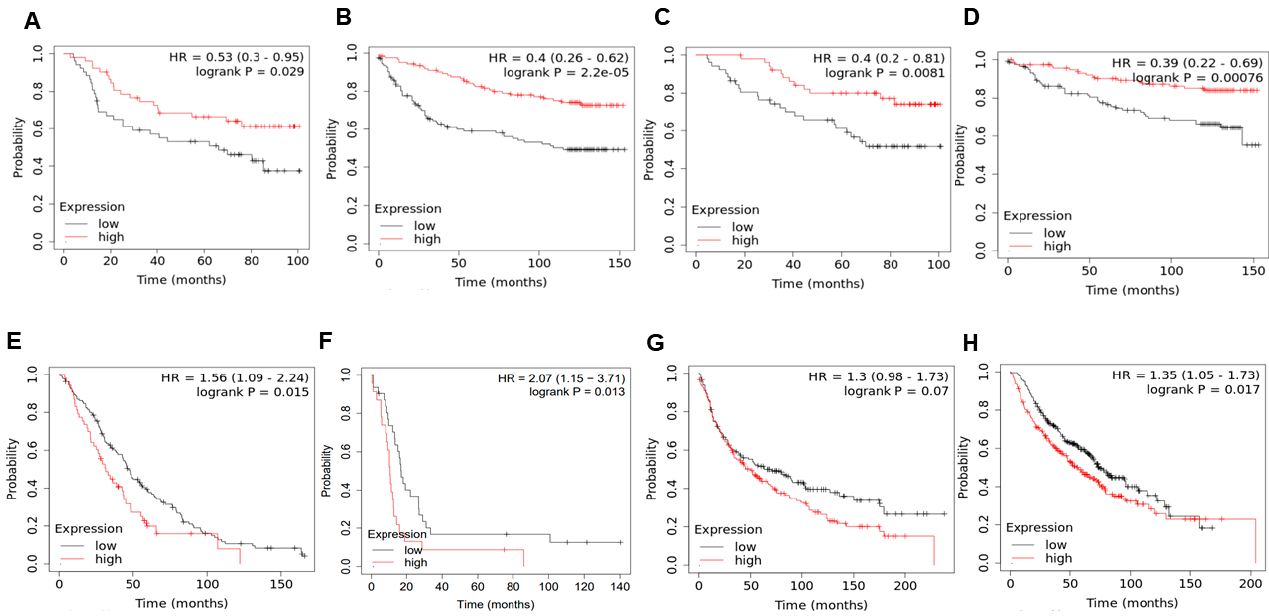
Figure 5. KLF4 correlates with patient survival in a cancer-specific manner. ( A , B ) Relapse-free survival trends in GSE42568 and GSE3494 (breast cancer), respectively. ( C , D ) Same as ( A , B ) but for the overall survival. ( E , F ) Overall survival trends in GSE26712 and GSE30161 (ovarian cancer), respectively. ( G , H ) Overall survival trends in GSE30219 and CaArray (lung cancer), respectively. HR denotes the hazard ratio, and logrank P denotes the p -value. The mean value and 95% confidence interval are shown. In panel B; 2.2e-05 means 2.2 × 10 − 5 .